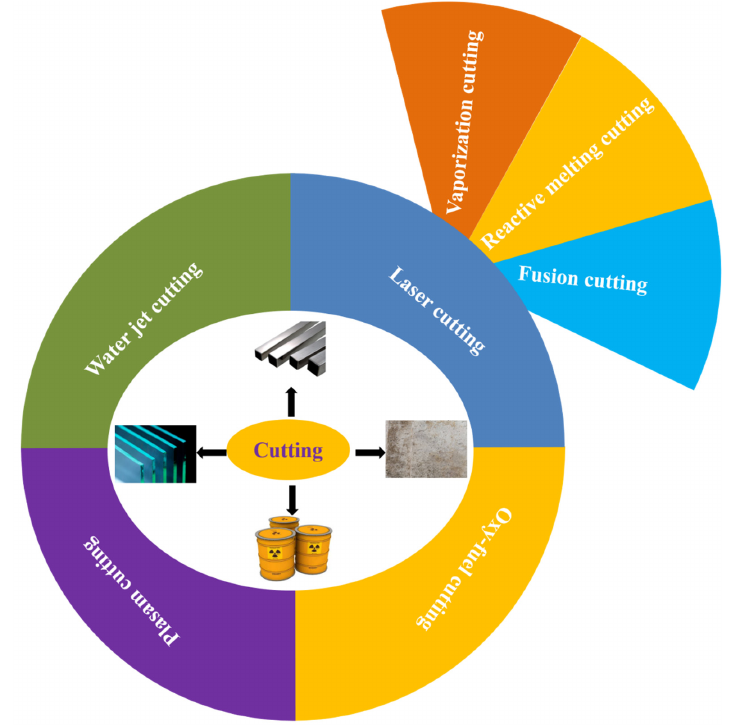
Figure 2. Laser cutting